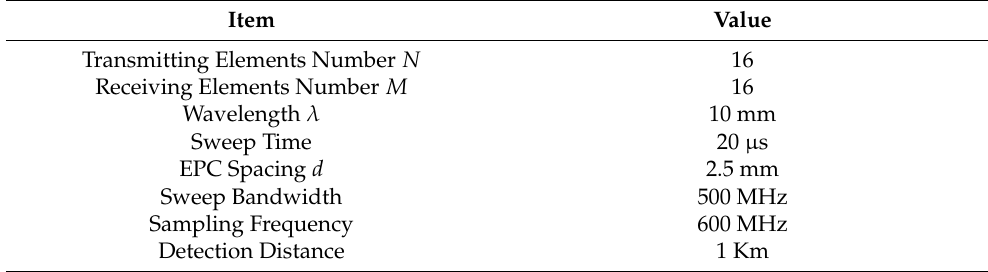
Table 2. Simulation parameters.